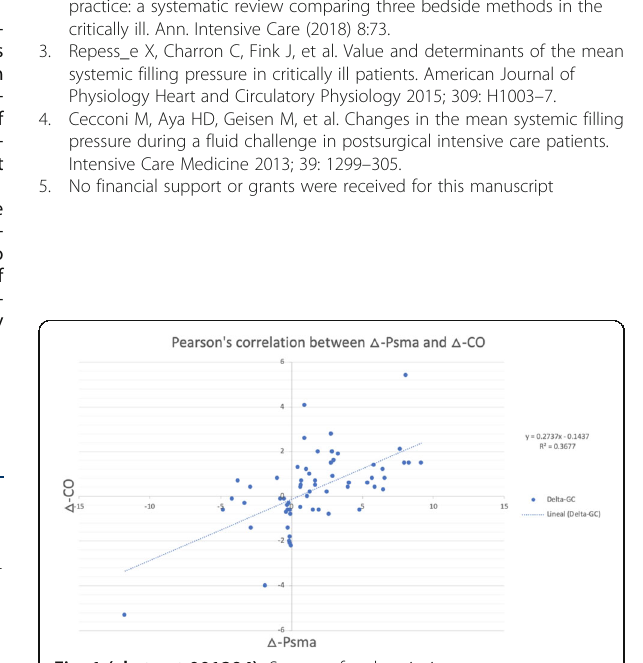
Fig. 1 (abstract 001294). See text for description